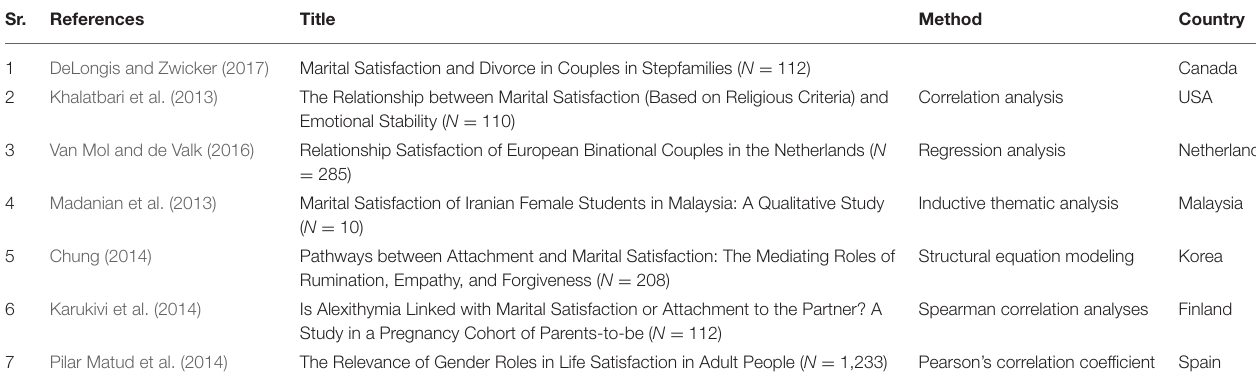
TABLE 1 | Data sources and methodologies of previous